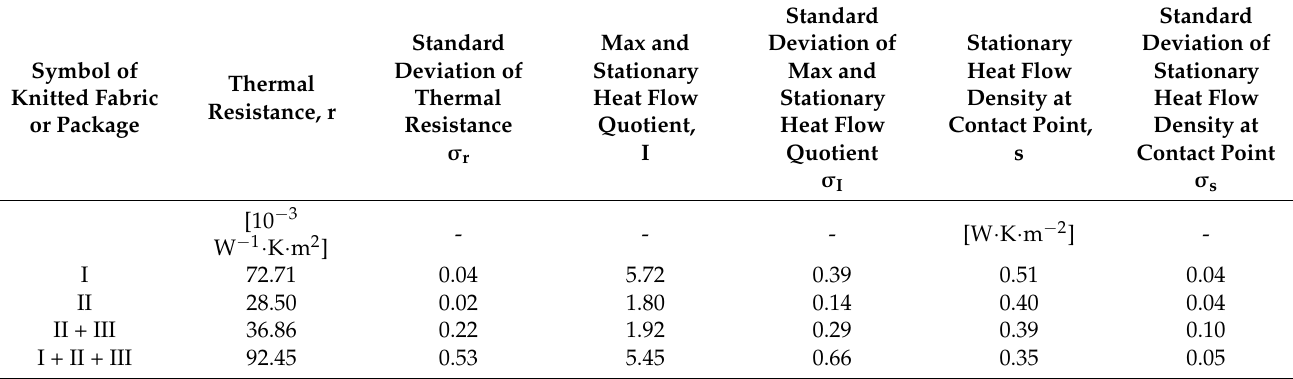
Table 7. A summary of the parameters measured on the Alambeta device.